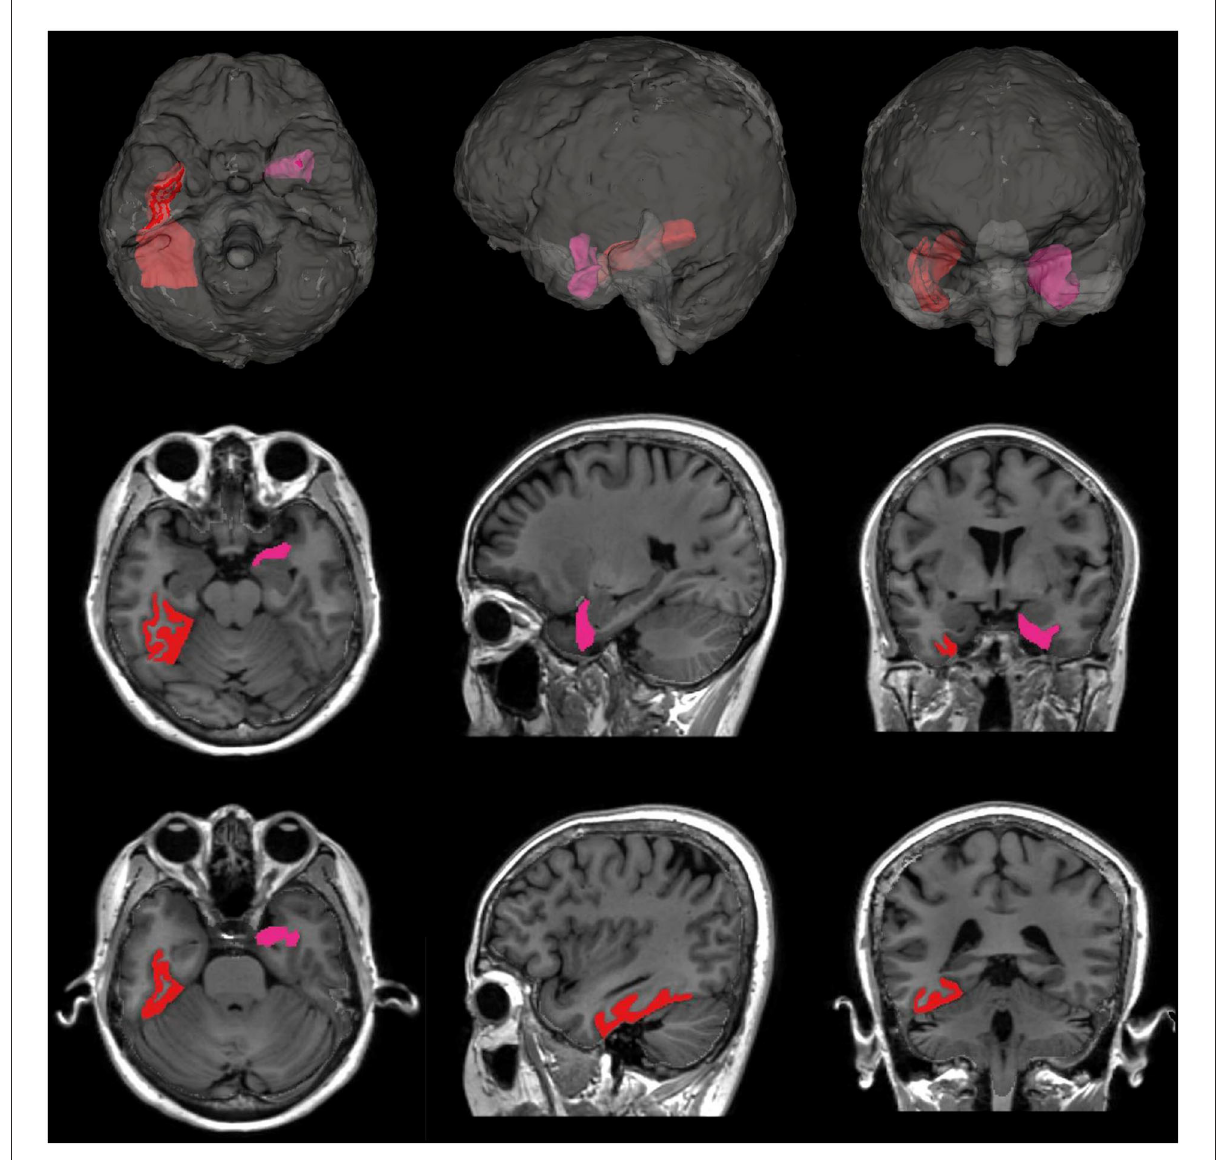
FIGURE2 Subregions of temporal GM with significant atrophy associated with night systolic BPV. The left entorhinal cortex (marked in pink, P = 0.010) and the right fusiform gyrus (marked in red, P = 0.039) showed significantly greater atrophy associated with increased night systolic BPV.